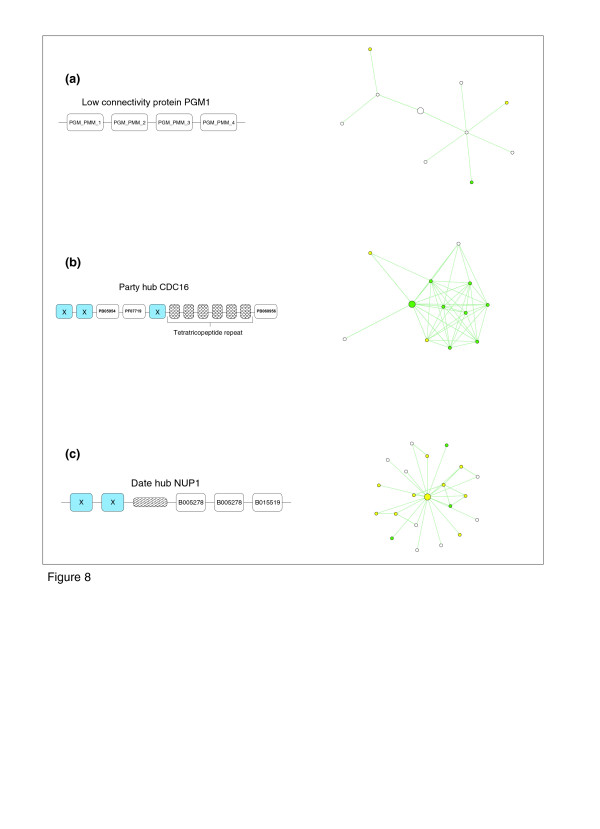
Neighbors of proteins of low connectivity (white nodes), party hubs (green nodes) and date hubs (yellow nodes); an example. a) Non-hub protein PGM1 (YKL127W, large node) is the metabolic enzyme phosphoglucomutase, which consists of four well characterized domains associated with phosphoglucomutase activity. PGM1 is only connected to two other proteins, which are not hubs. b) Party hub protein CDC16 (YKL022C, large node) is an essential protein and is part of the anaphase-promoting complex (APC). It contains six tetratricopeptide domains, one additional Pfam-A domain, two Pfam-B domains and three orphan domains (blue rectangles). CDC16 interacts with party hubs, date hubs as well as two IC and NH proteins. c) Date hub protein NUP1 (YOR098C, large node) is a nuclear pore complex protein of diverse function which contains three Pfam-B domains, two orphan domains and one long disordered region (dashed). It interacts with other date hubs, party hubs and several non hub proteins. The network figures were drawn using BioLayout[52].